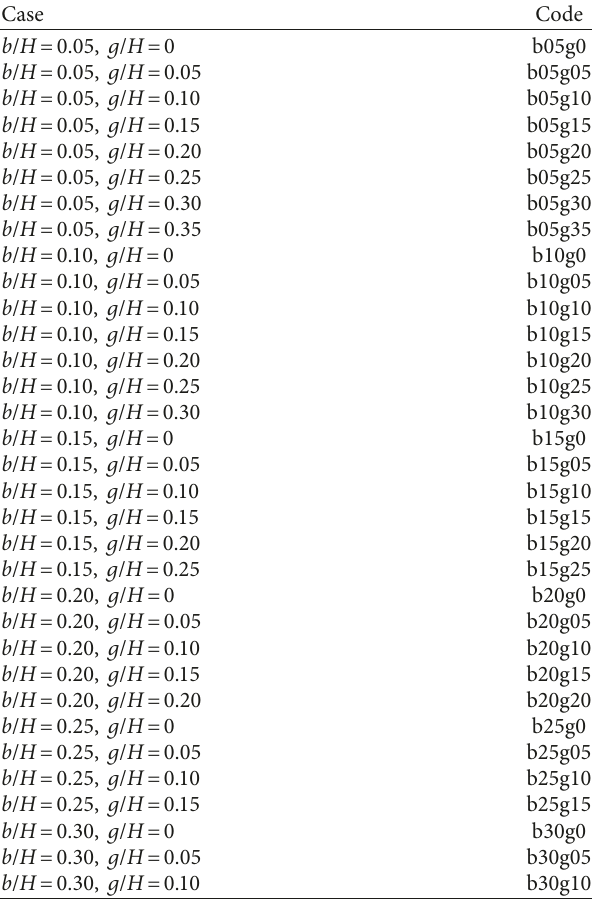
Table 1: Case study.